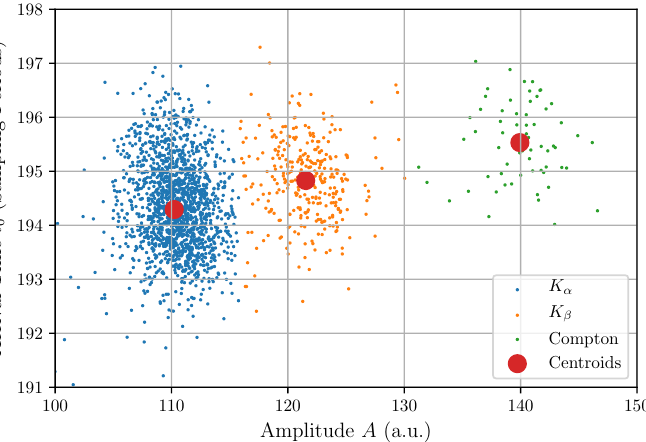
Figure 15. Scatter plot of amplitudes and arrival times with colored clusters and corresponding